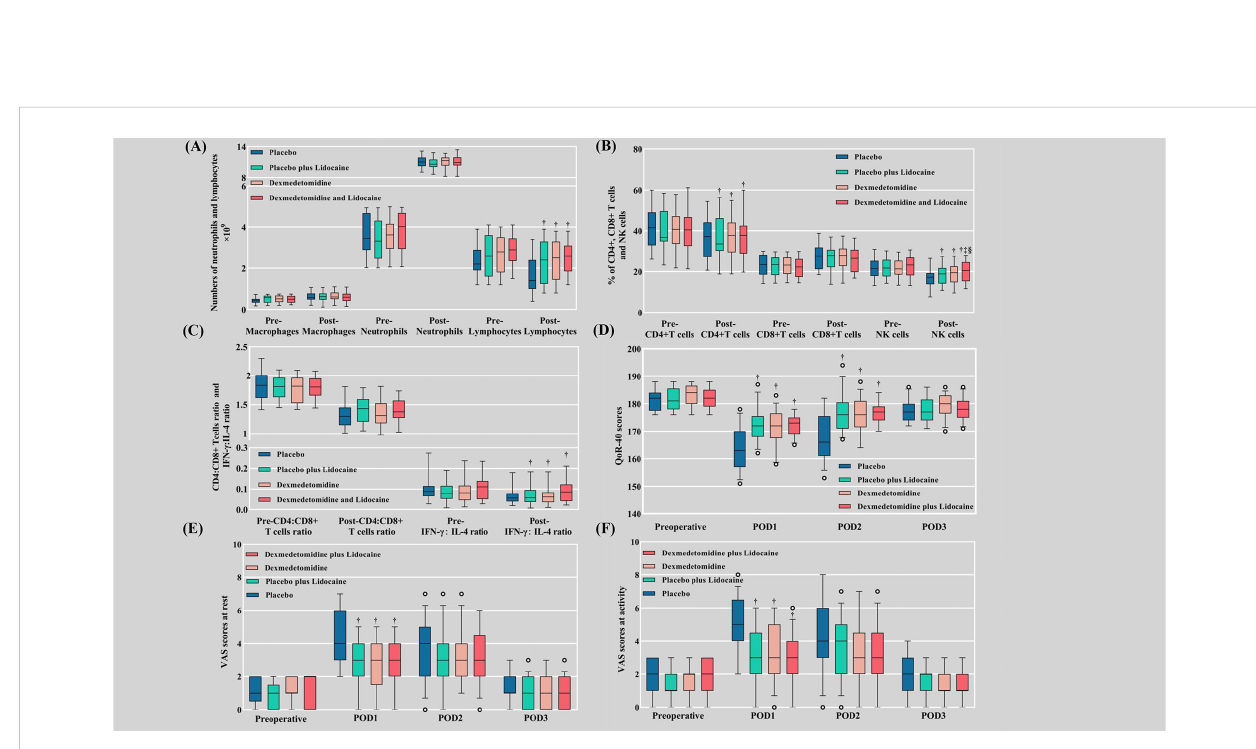
FIGURE 3 Cellular immune function, VAS scores, and QoR-40 scores. (A) Numbers of macrophages, neutrophils, and lymphocytes; (B) Percentages of CD4+ T cells, CD8+ T cells, and NK cells; (C) The ratios of CD4+:CD8+ T cells and IFN- g :IL-4; (D) QoR-40 scores; (E) VAS scores at rest; (F) VAS scores at activity. Pre, preoperative; Post, postoperative; VAS, visual analog scale; QoR-40, Quality of Recovery 40; POD, postoperative day. † Compared with the placebo group (C), the difference was statistically signi fi cant. ‡ Compared with the placebo plus lidocaine group (L), the difference was statistically signi fi cant. § Compared with the dexmedetomidine plus placebo group (D), the difference was statistically signi fi